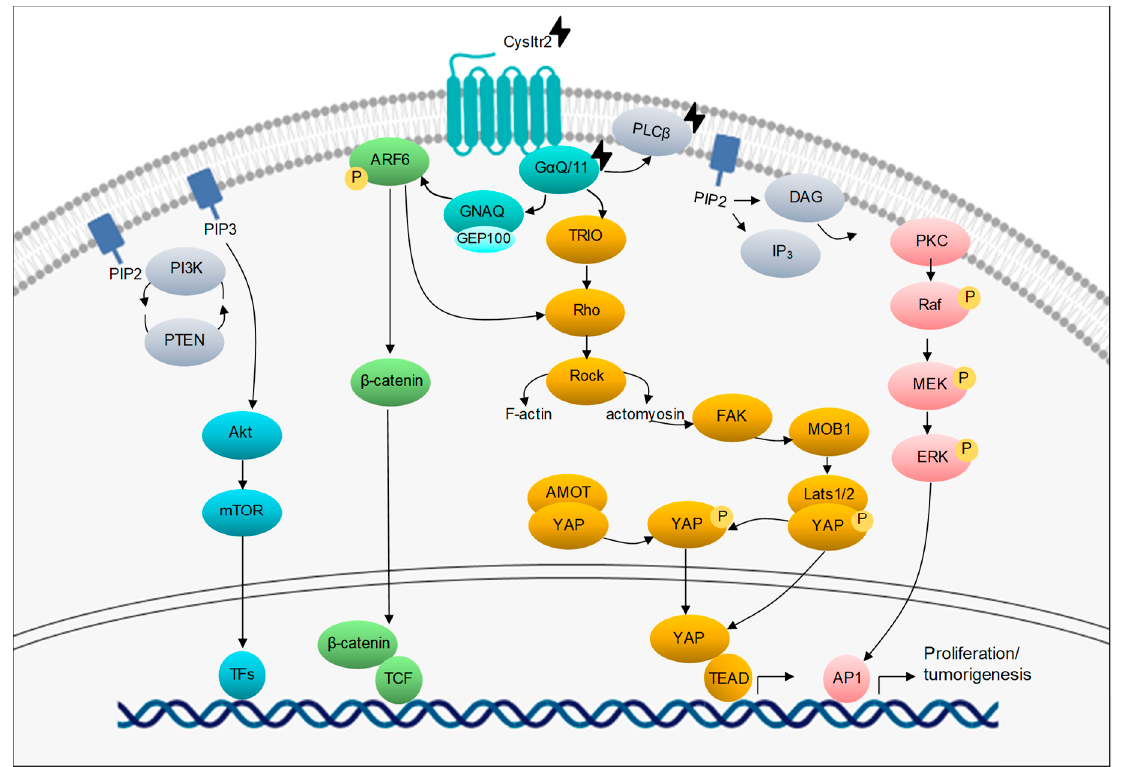
Figure 1. Genomic and genetic alterations in uveal melanoma (UM) and the affected biological processes. ( a ). Frequency of mutations in UM and the associated prognostic value: BRCA1 associated protein 1 ( BAP1) mutations are mostly associated with chromosome 3 monosomy and an early metastatic risk (~5 years after primary UM diagnosis), splicing factor 3b subunit 1 ( SF3B1 ) and serine/arginine-rich splicing factor 2 ( SRSF2 ) mutations are mainly associated with chromosome 3 disomy and a late-onset metastatic risk (~8 years after primary UM diagnosis), while eukaryotic translation initiation factor 1A X-linked ( EIF1AX ) mutations are associated with chromosome 3 disomy and a low risk of metastasis. Data is retrieved from The Cancer Genome Atlas (TCGA) UM dataset (cBioportal for Cancer Genomics) [56,57]. ( b ). Main biological processes impacted by the recurrent mutations in UM. Mutations in components of G protein-coupled receptors (GPCRs) lead to the constitutive activation of G α q signaling and several downstream pathways. Further oncogenic events include mutations in BAP1 , SF3B1/SRSF2 , or EIF1AX , involved in chromatin modulation, splicing, and translation initiation, respectively. Mutations are indicated by